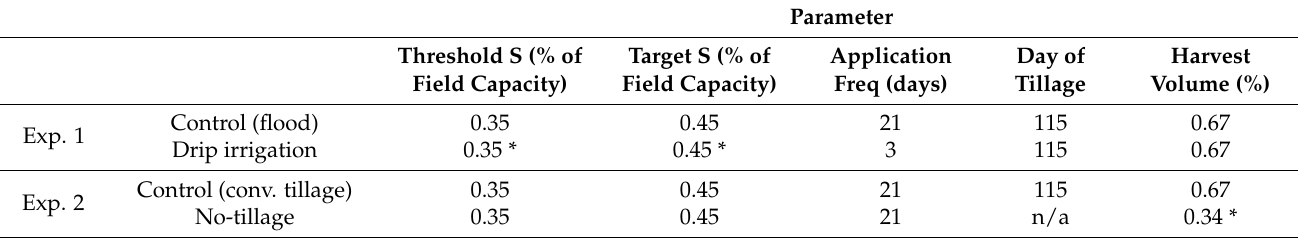
Table 4. Summary of the two simulation experiments indicating assumed parameter (control) and hypotheses (treatments) values: threshold and target soil moisture levels, S, irrigation application frequency, day of year of tillage event, and harvest volume percentage. * Parameters indicate initial values subject to change given heuristic decision adjustments over